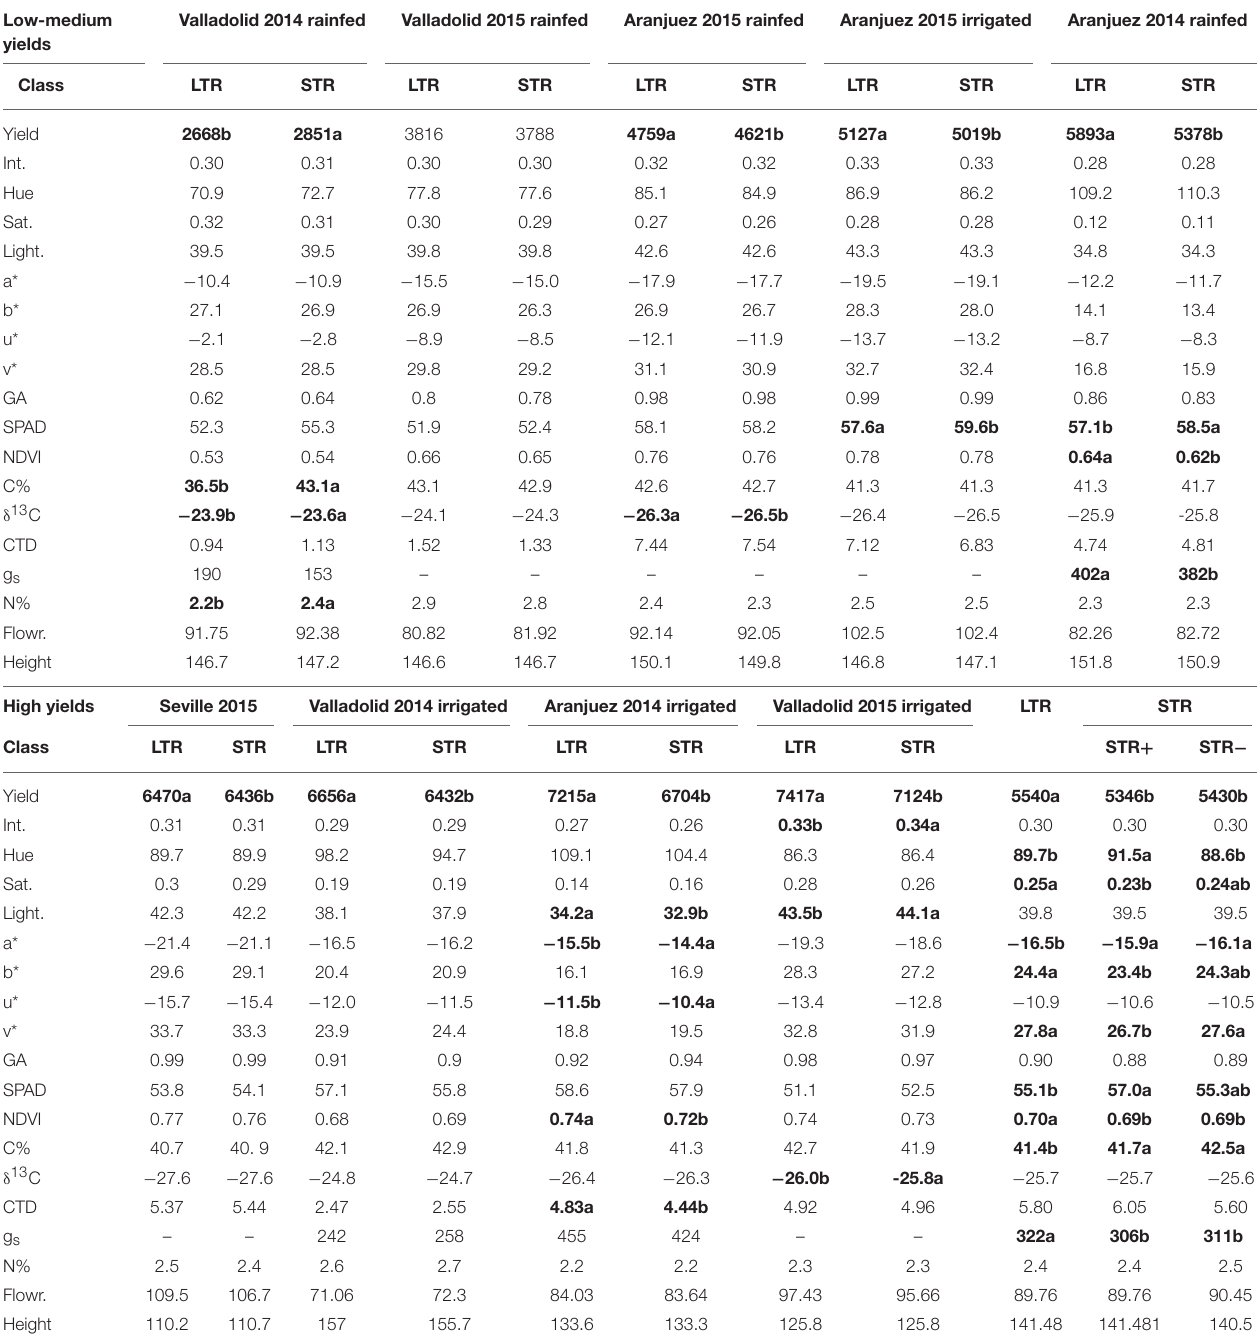
TABLE 4 | Differences in grain yield, vegetation indices and water regime parameters between the linear transpiration (LTR) and segmented transpiration (STR) groups within each of the nine field growth conditions assayed. Low-medium